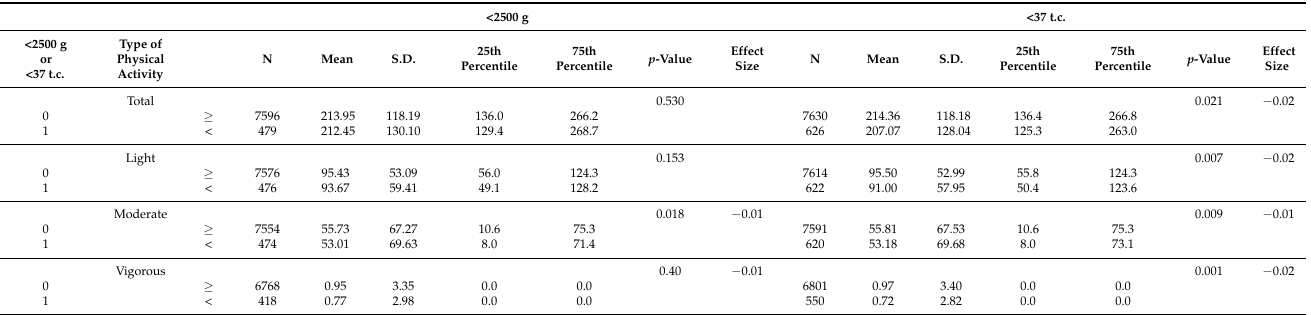
Table 5. Impact of energy expenditure of pregnant women (MET-h/week) on the birth of the child with the birth weight under 2500 g and before the 37th week of pregnancy. <2500g